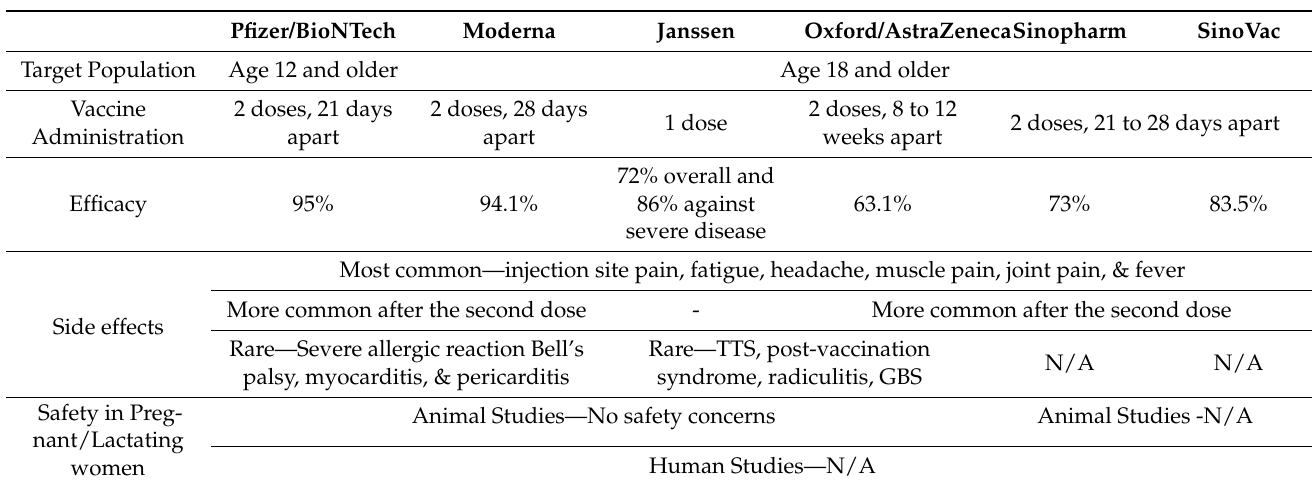
Table 1. COVID vaccines granted an Emergency Use Authorization (EUA) by Federal Drug Administration (FDA) and/or Emergency use listing (EUL) by